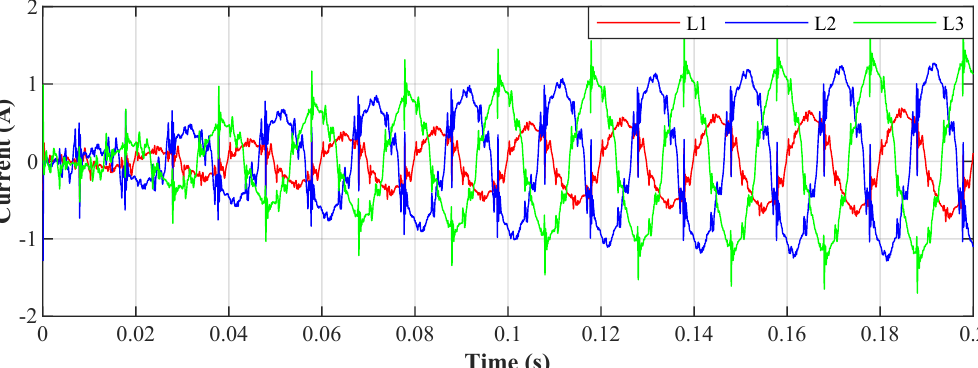
Figure 14. Idle run of test polygon; current waveforms after applying the least mean squares (LMS)